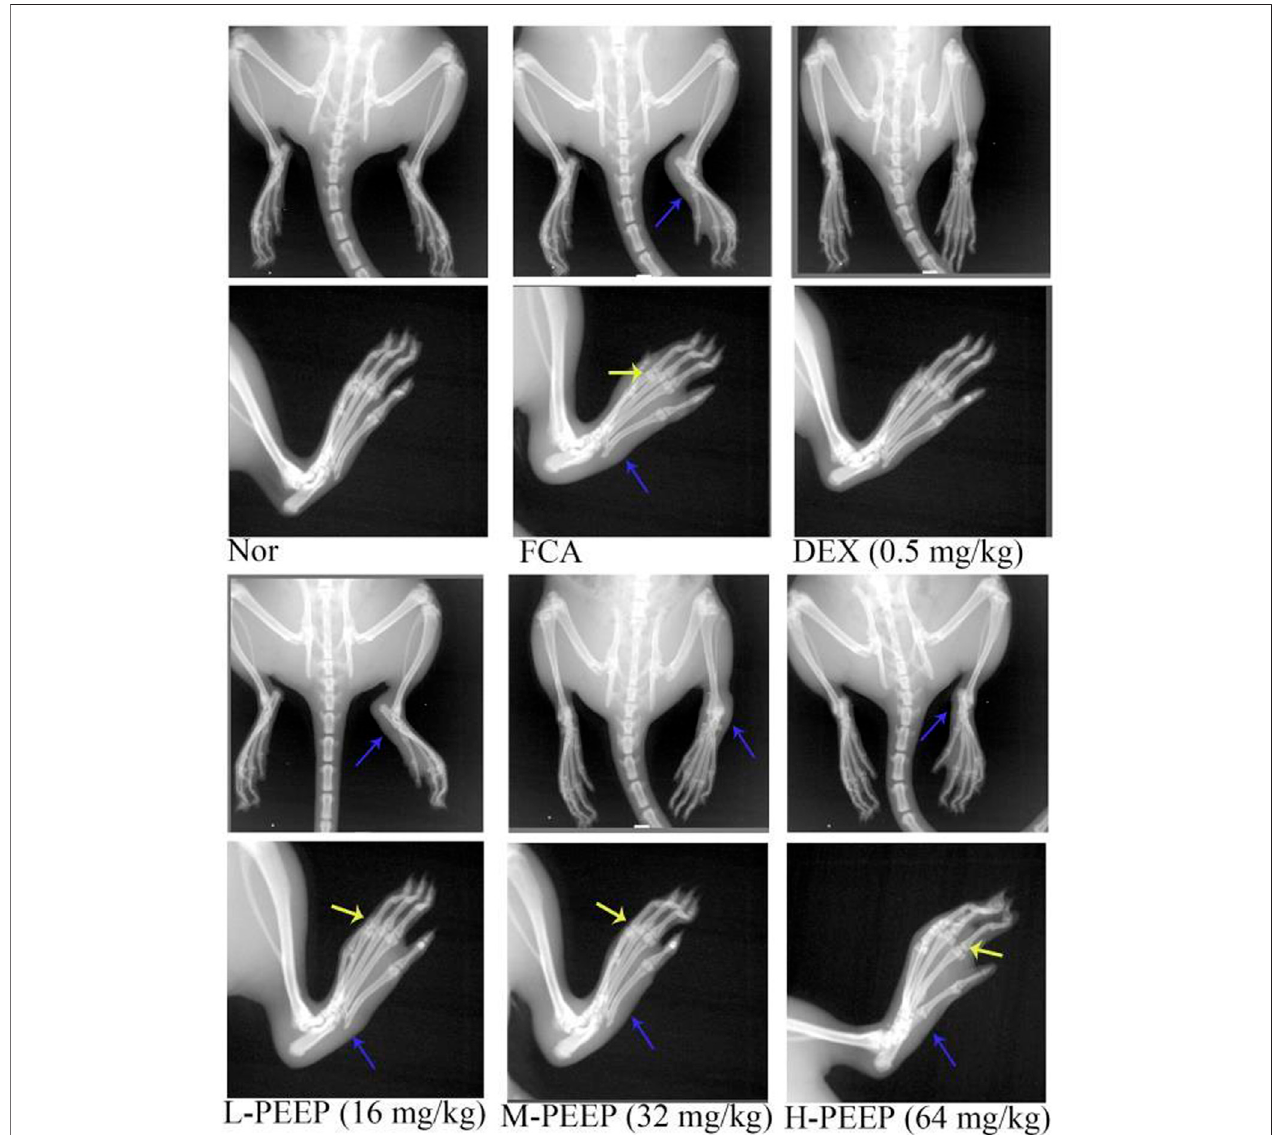
FIGURE 7 | X-ray evaluation of joint injury in CFA rats. X-rays showed the effects of different doses of PEEP on hind paw and right paw of CFA rats. Blue arrow, swelling of soft tissue; yellow arrow, narrow joint space, blurred joint surface.